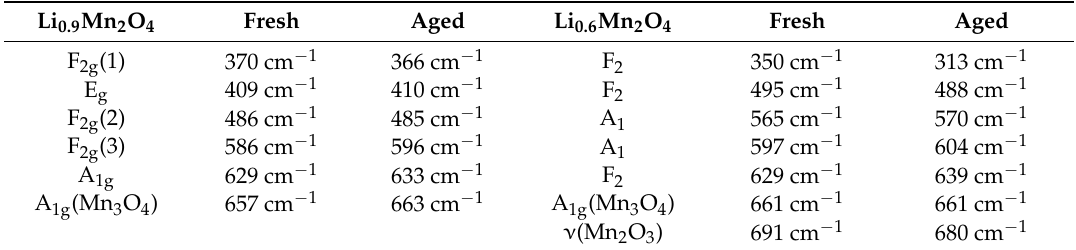
Table 2. Raman bands observed in spectra from LMO cathodes and correspondent vibrational modes.